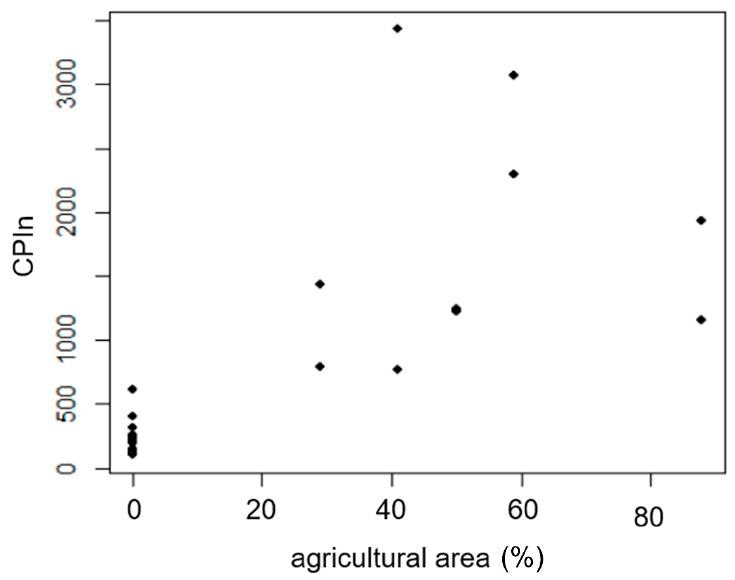
Figure 6. Scatterplot showing the relationship of CPIn of both years and the percentage of agricultural area within a 100 m radius of each sampling location.